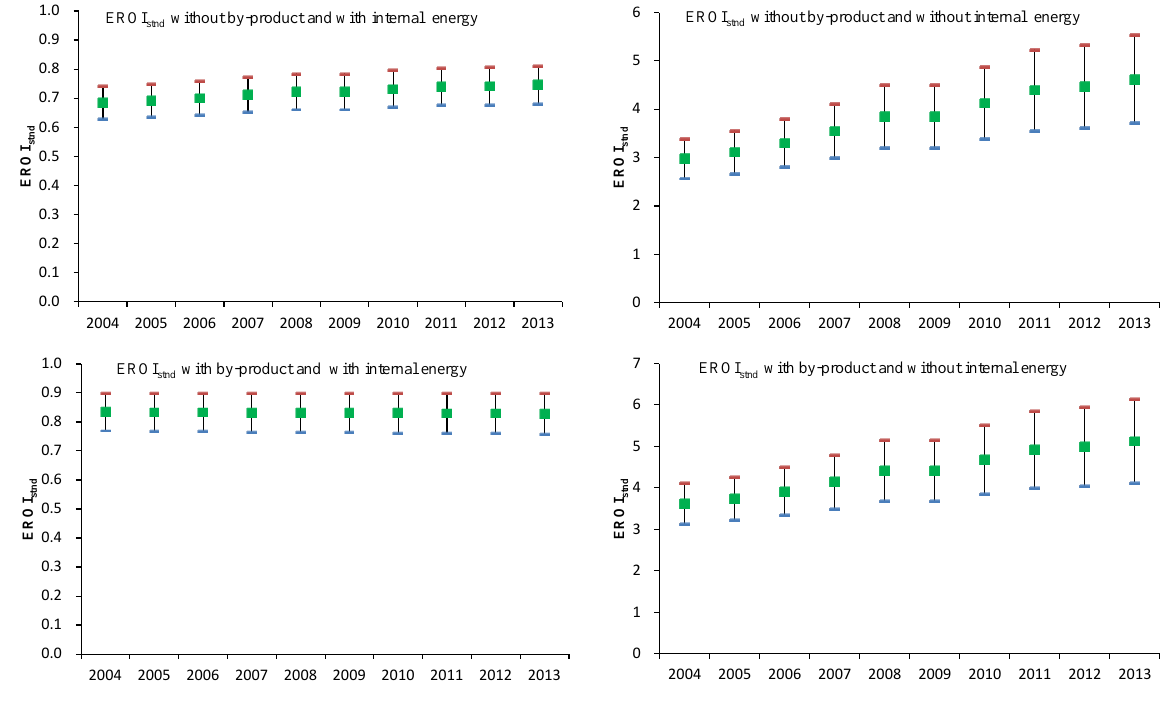
Figure 5. The change of EROI stnd value caused by the varying energy intensity.